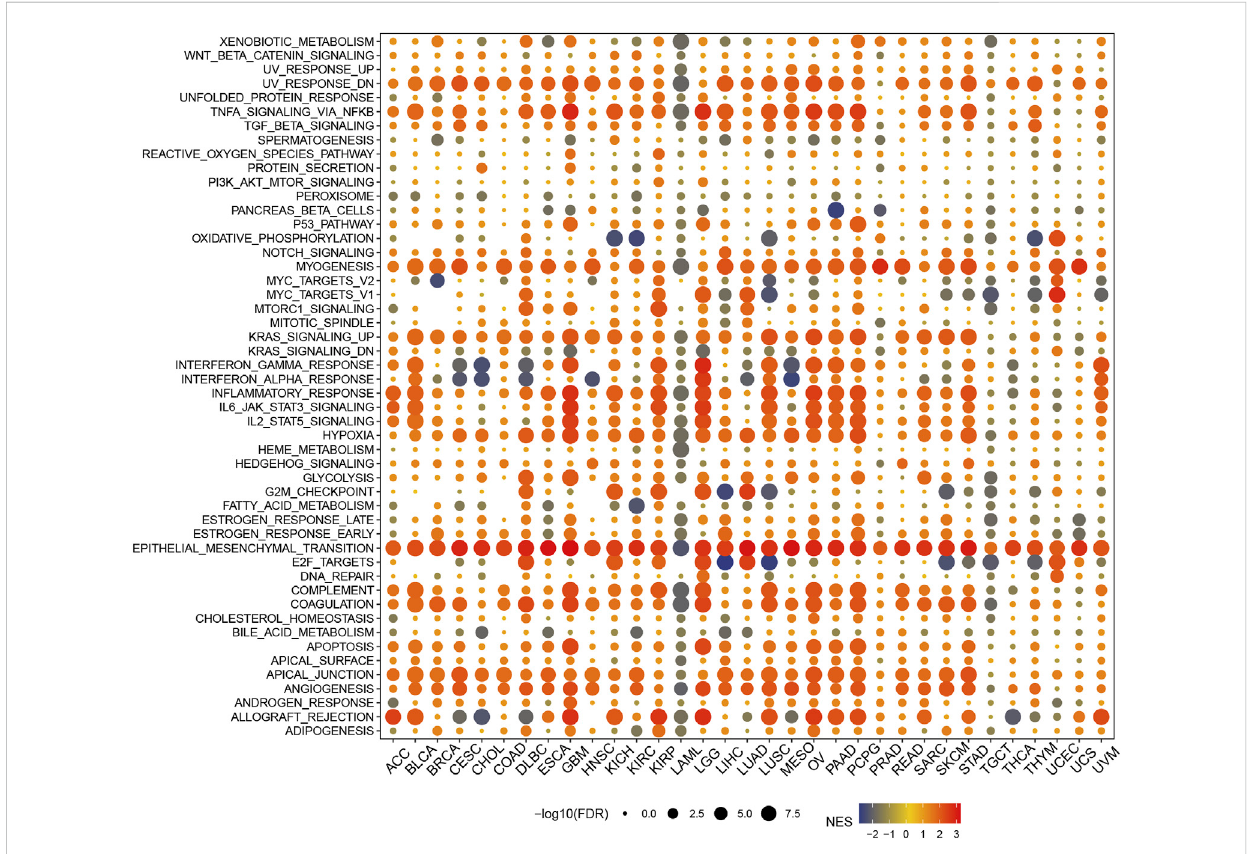
FIGURE 10 The hallmarks gene set enrichment analysis (GSEA) of P4HA3 in pan-cancer. The circle size represents each cancer enrichment item ’ s false discovery rate (FDR) value, and the color represents the normalized enrichment score (NES) of each enrichment